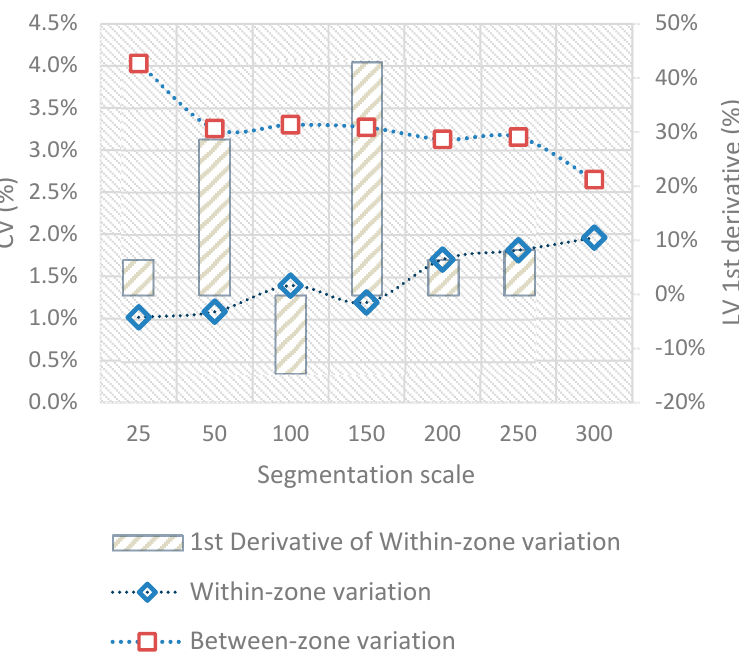
Figure 5. Within-zone and between-zone variation (computed as CV%) for an experimental sequence of segmentation scale factors (25 to 300) for the multi-temporal RapidEye PC1